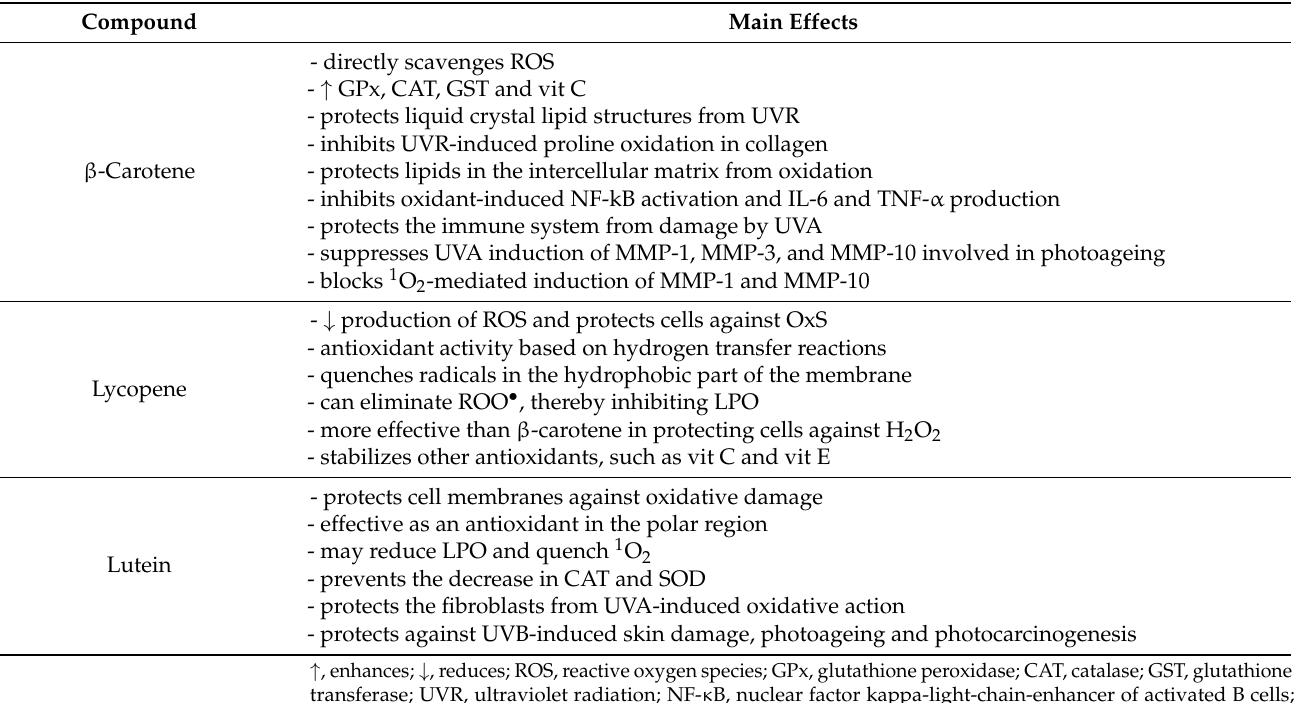
Table 4. Antioxidant activity of dominant carotenoids present in human skin